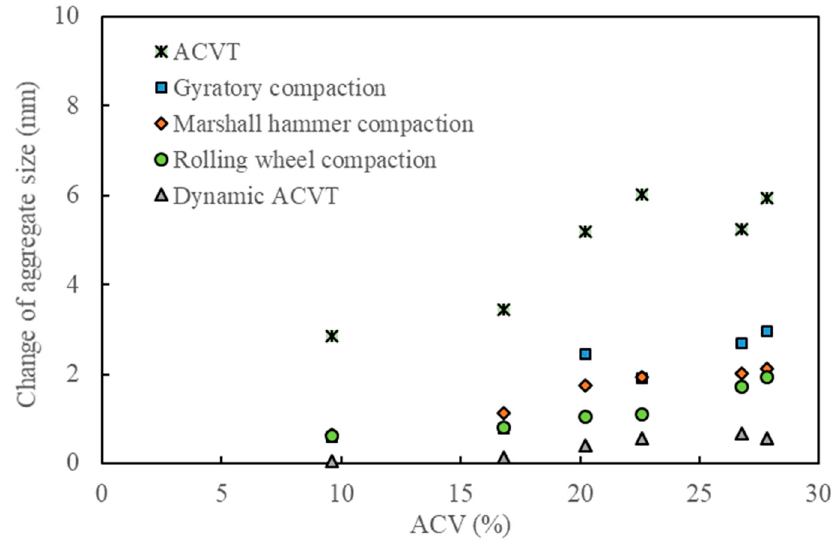
Figure 13. Effect of ACV on the change of aggregate size under various loading methods.